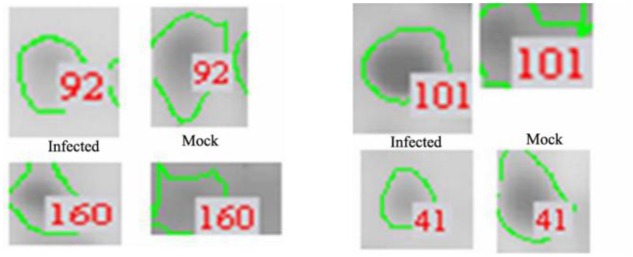
Enlarged regions of several differentially expressed protein spots. Differentially expressed protein spots are indicated by numbers and circles.